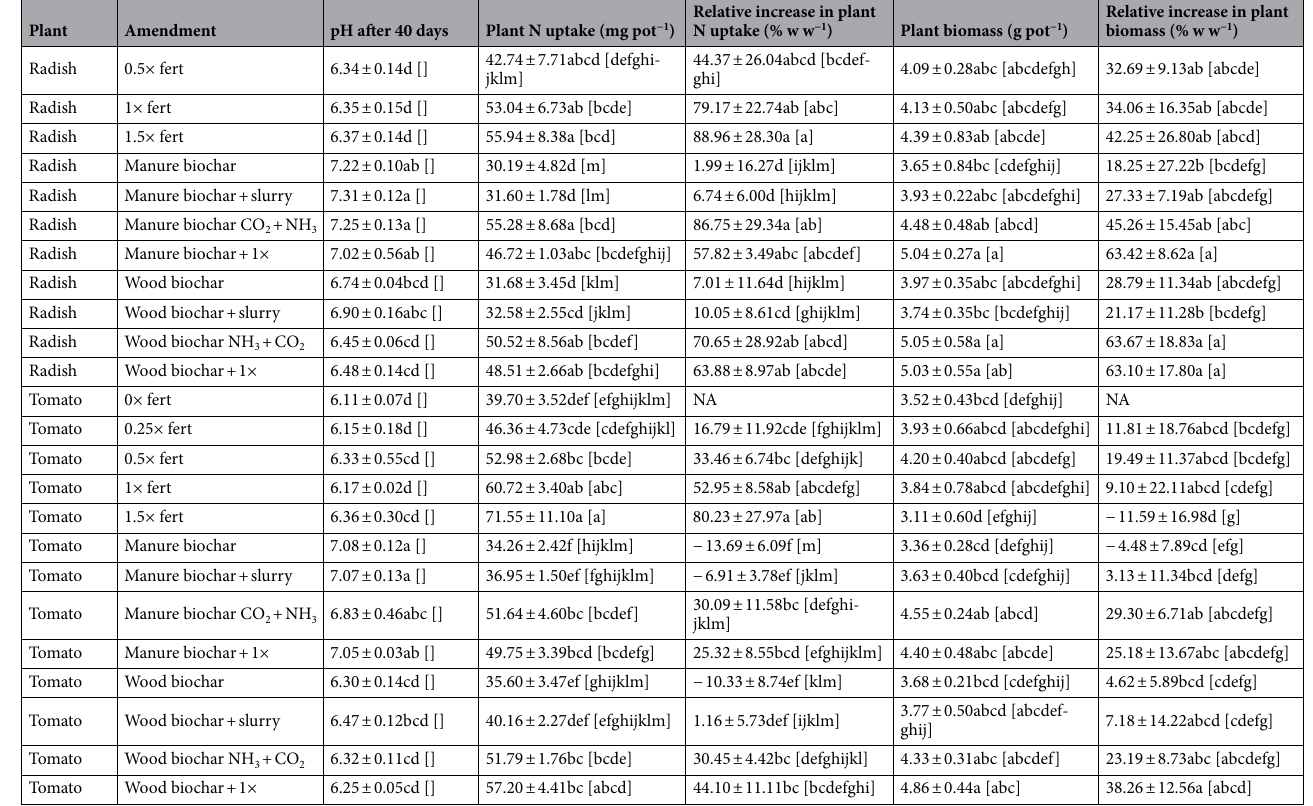
Table 4. The average ± standard deviation of the pH of potting mix and amendments after 40 days, total plant biomass (shoot and root combined) and relative increase in plant biomass relative to unamended plants (0×), total N plant uptake (shoot and root combined), and relative increase in biomass N uptake in comparison to unamended plants. Letters indicate significant differences from a one-way anova between amendments within plant type (p < 0.05; n = 4; results for a two-way anova include in supplementary online material Table SI